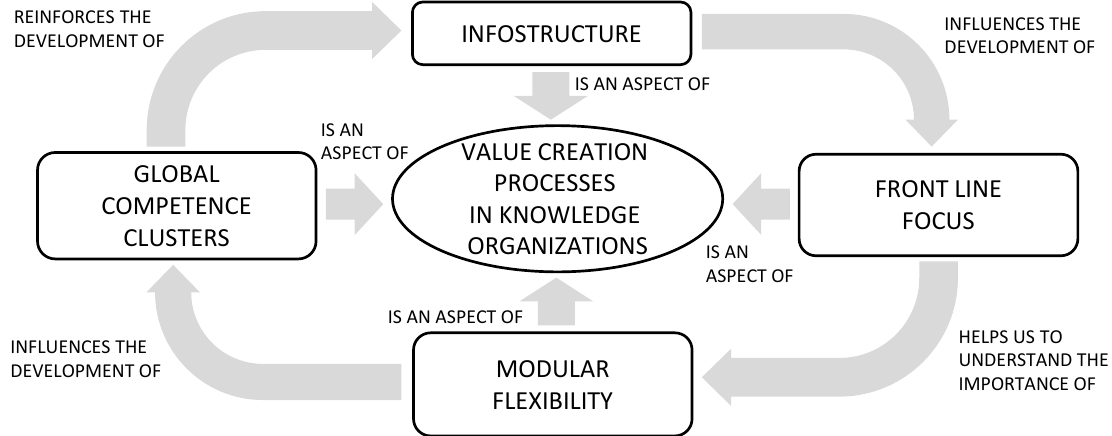
Figure 1 . Key value creation processes in the knowledge